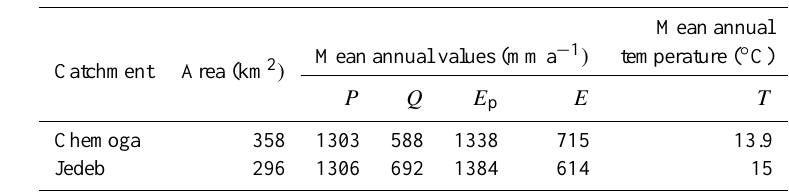
Table 1. Descriptions of hydro-meteorological characteristics of investigated catchments (2008–2010). P , Q , E p , and E stand for catchment average precipitation, runoff, potential evaporation and actual evaporation, respectively.